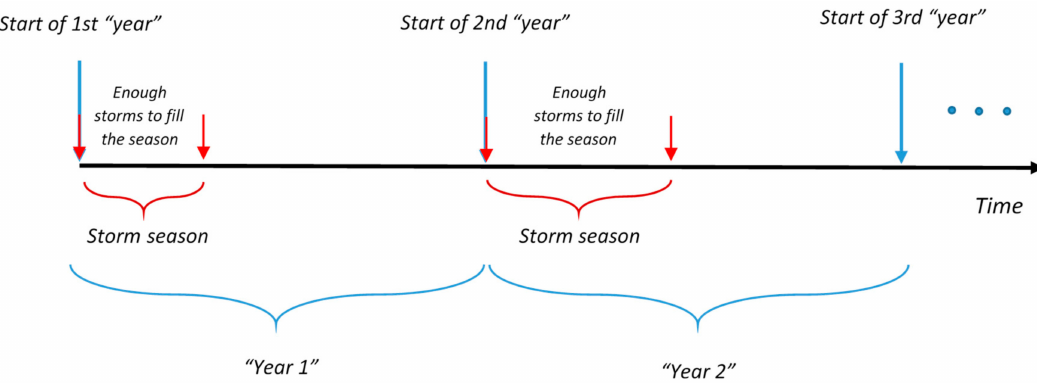
Figure 15. Schematic illustrates the algorithm used for constructing one long-term record of